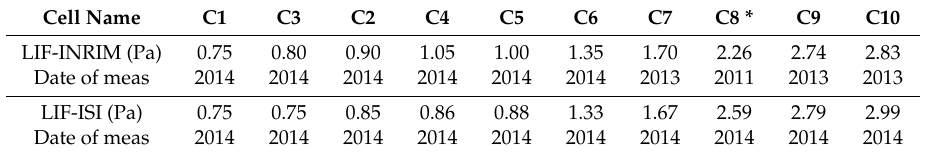
Table 2. Comparison of the measurements of the original (INRIM) and upgraded (ISI) LIF setups performed on the same 10 pieces iodine cell set. * The progress in C8’s iodine purity degradation was probably caused by a small leakage on the cell body (release of contaminants during the four-year-long period).